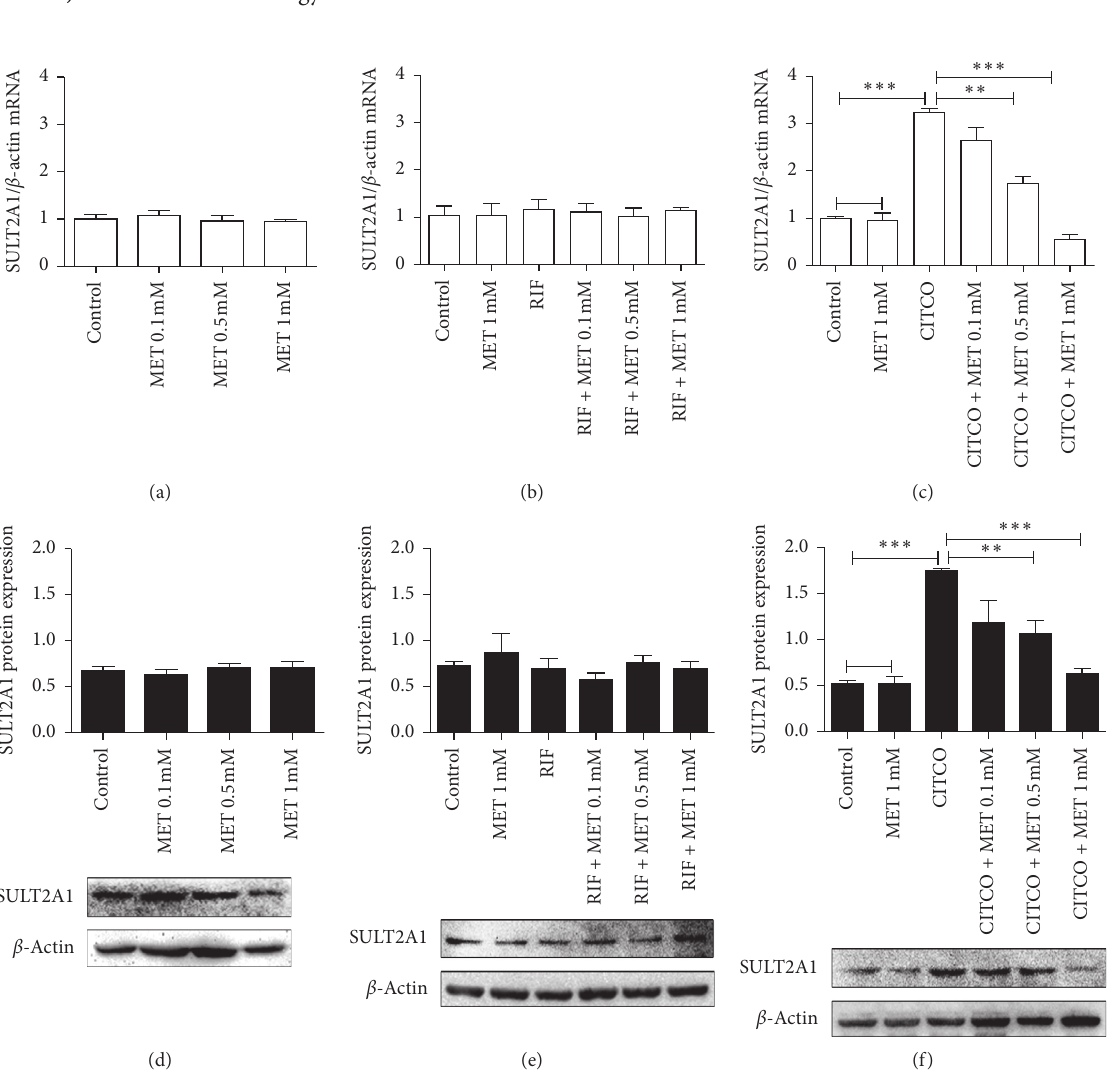
Figure 2: Metformin represses CITCO-induced SULT2A1 expression. (a–c) HepaRG cells were treated with RIF (20 μ M), CITCO (1 μ M), metformin (0.1, 0.5, 1mM), or their combination for 24h. Cells treated only with DMSO were considered as the control group. Total mRNA was collected and the expressions of SULT2A1 and β -actin were analyzed using real-time PCR. Values were normalized to the expression of β -actin. (d–f) HepaRG cells were treated with RIF (20 μ M), CITCO (1 μ M), metformin (0.1, 0.5, 1mM), or their combination for 48h. Whole-cell extracts were harvested, and the expression of SULT2A1 and the internal control β -actin were analyzed using western blotting. Quantitation of the SULT2A1 protein bands was normalized to β -actin. A representative blot was shown and quantified by Image J software. The data shown are the mean ± SEM ( n � 3) ( ∗∗ P < 0 . 01 and ∗∗∗ P < 0 . 002, comparison indicated by brackets. ns: not